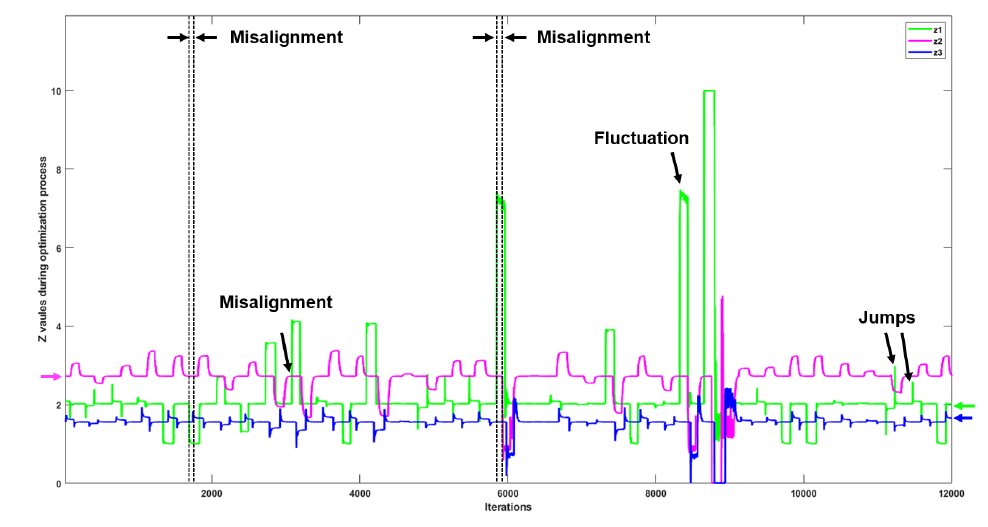
Figure 9. The z values of devices 1, 2, and 3 during the update process in the PS. The misalignments, fluctuations, and jumps can affect the performance of detection when detecting anomalies in real- world